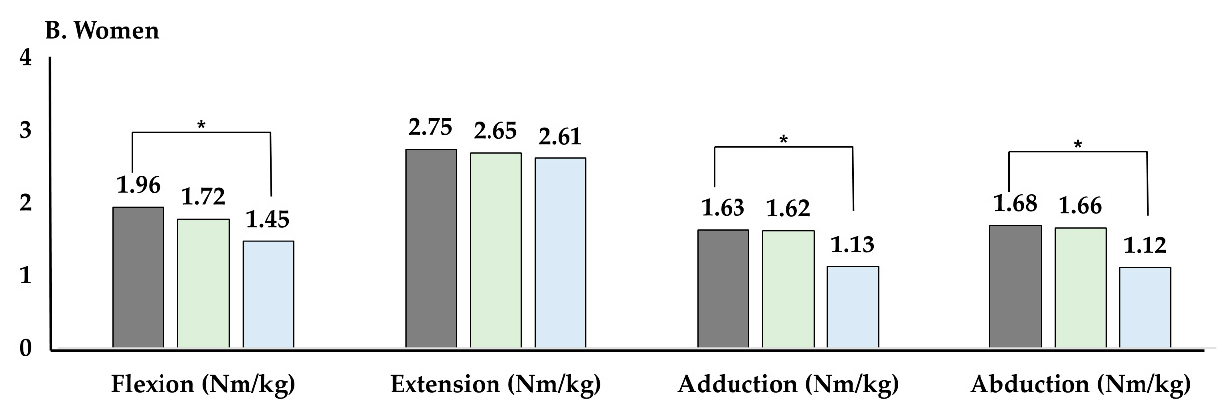
Figure 4. Comparison of isokinetic strength in healthy, asymptomatic and symptomatic femoroacetabular impingement patients. * p < 0.05, significance. Abbreviations: FAI, femoroacetabular impingement; sym, symptomatic; asym, asymptomatic; Nm, Newton meter.